Question: Give a one-sentence summary of this figure.
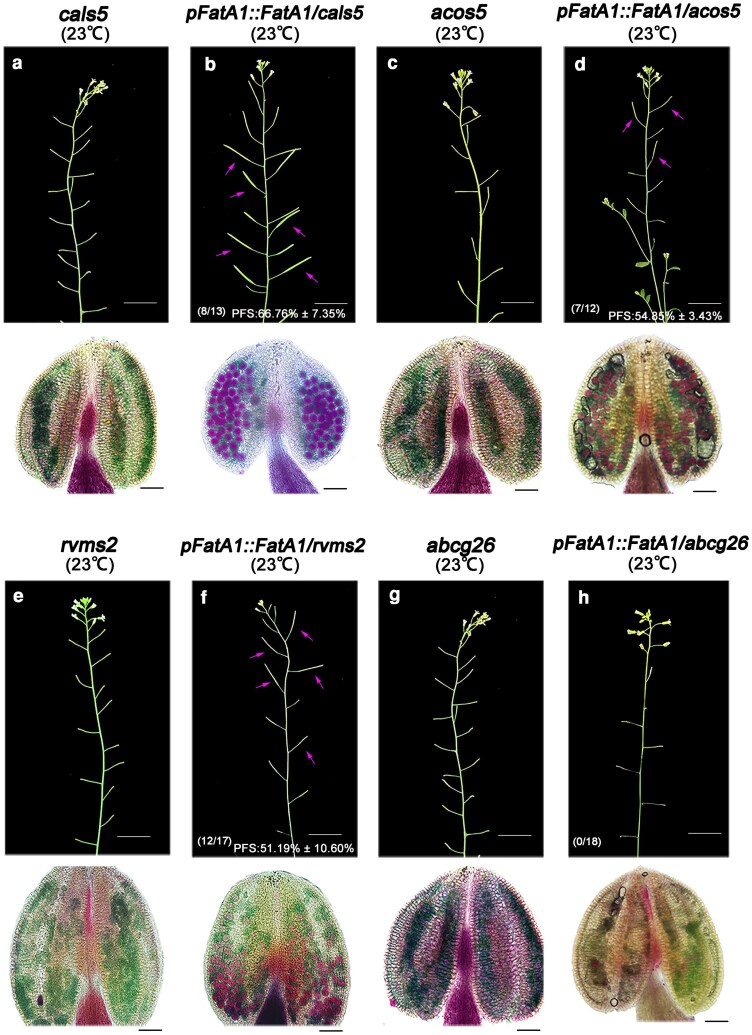
Answer: Fertility restoration in TGMS mutants by overexpression of FatA1 . The p FatA1::FatA1 construct was introduced into cals5 a and b), acos5 c and d), rvms-2 e and f), and abcg26 g and h) mutants. Fertility was partially rescued in cals5 , acos5 , and rvms2 transgenic plants. Numbers indicate fertile transgenic lines (eg, 8/13 denotes 8 fertile lines out of 13 independent transgenic lines). Magenta arrows indicate elongated, fertile siliques. The percentage of fertile siliques (PFS, mean ± Sd ) was calculated from 3 independent fertile transgenic lines ( n ≥ 20 siliques per line). Scale bar = 2 cm for the images of adult shoots and 50 μm for Alexander-stained anther images.